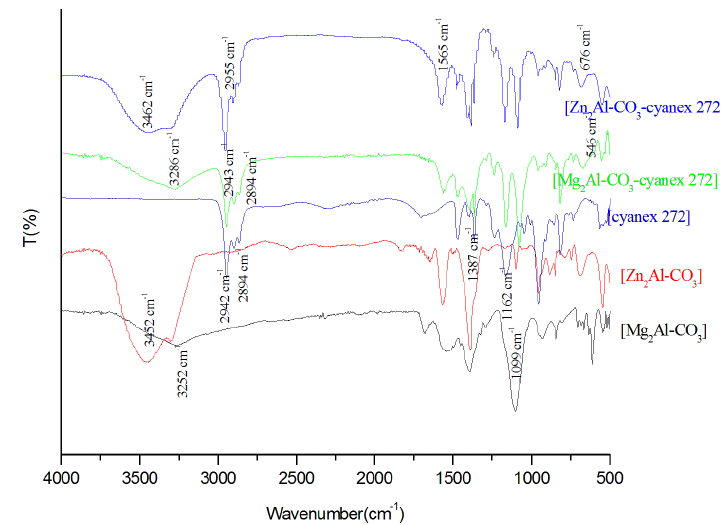
Figure 3. FTIR spectrum of Mg 2- Al-CO 3 , Zn 2- Al-CO 3 , Mg 2 Al-CO 3 -cyanex 272, Zn 2 Al-CO 3 -cyanex 272, and cyanex